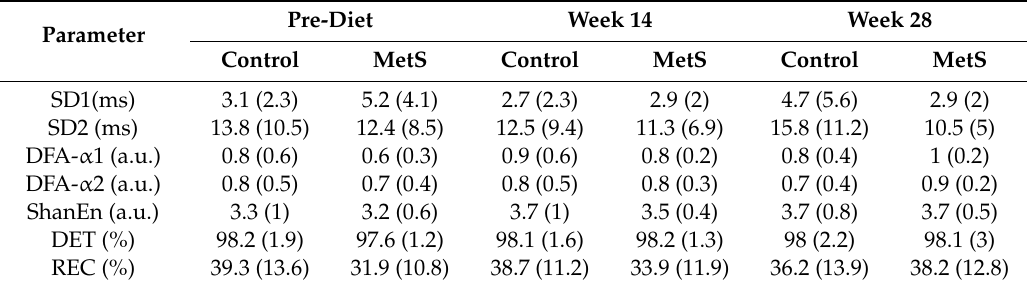
Table 3. Nonlinear parameters of short-term HRV